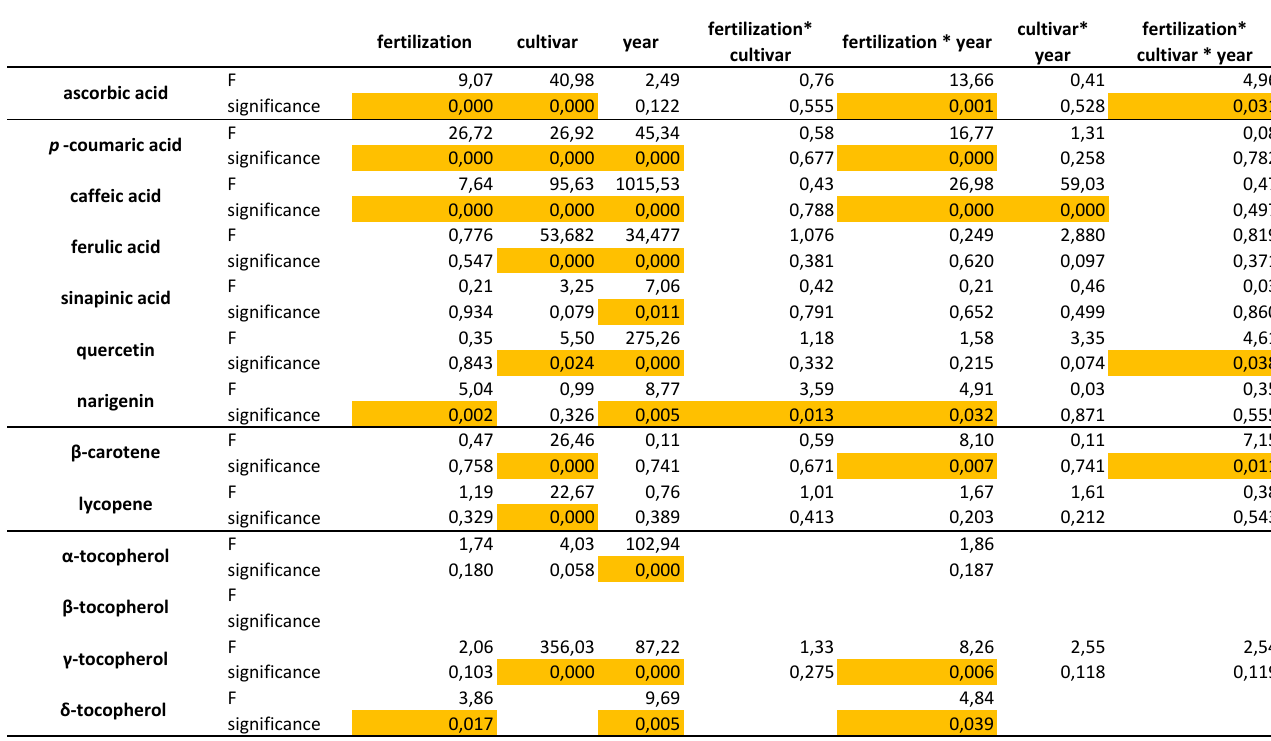
Table S3: Results of multi-factorial analysis of variance (ANOVA) performed for the categorical variables “fertilization level”, “cultivar”, and “year”as well as each measurement variable.